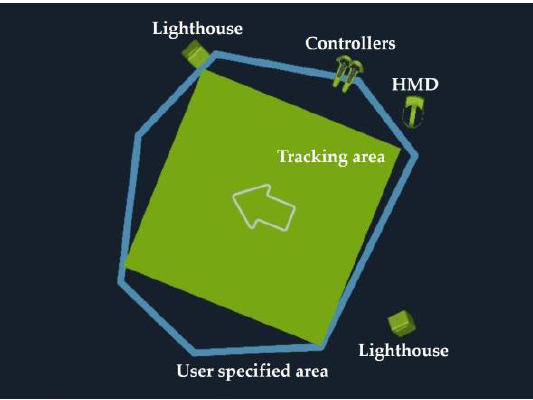
Figure 12. The 2.4 × 2.4 m 2 play area used for evaluation. On both sides, the lighthouses are looking at each other. During the installation process, this green area is automatically created by drawing a blue line through a controller. The HMD is tracked only within the green area.